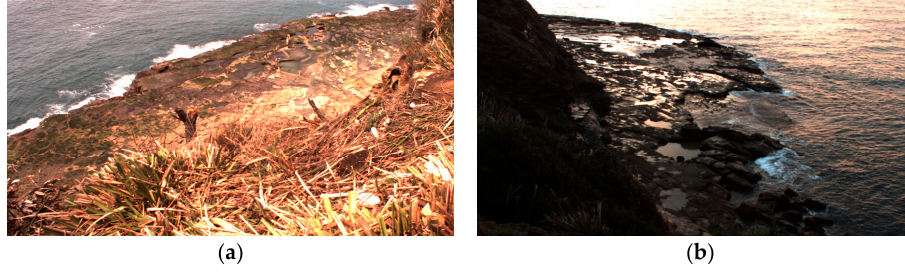
Figure 12. Still images from the cameras showing instances where the lighting and pixel color was challenging for automated inundation analysis: ( a ) north camera at 12:00 on 22 March 2017 showing very bright pixels on the landward edge of the rock platform, and ( b ) south camera at 07:00 on 22 March 2017 showing high levels of sun glint from both the ocean and the standing water on the platform.